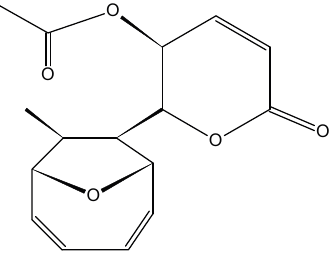
Figure 12. Mycoepoxydiene (MED, 31